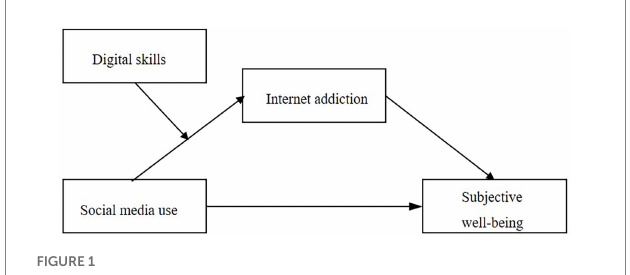
FIGURE 1 The conceptual mode of this